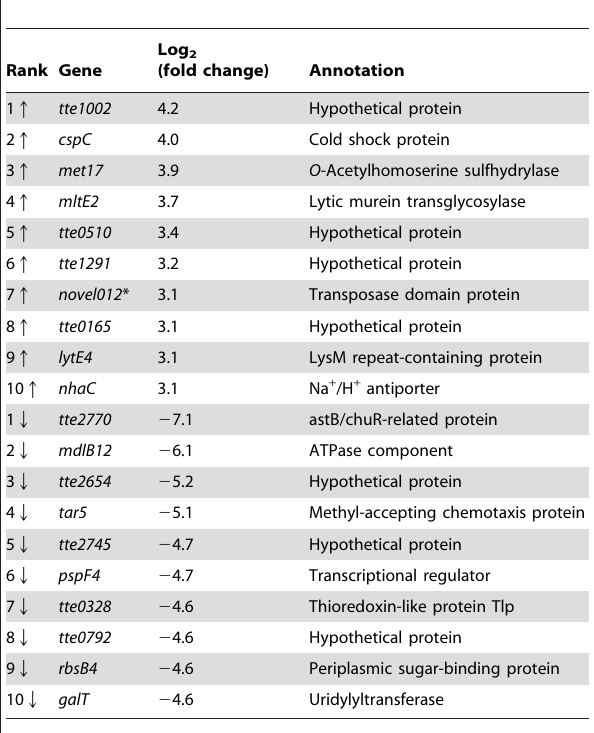
Table 2. Top ten up- and downregulated T. tengcongensis genes after cold shock at 50 u C for 1 h.